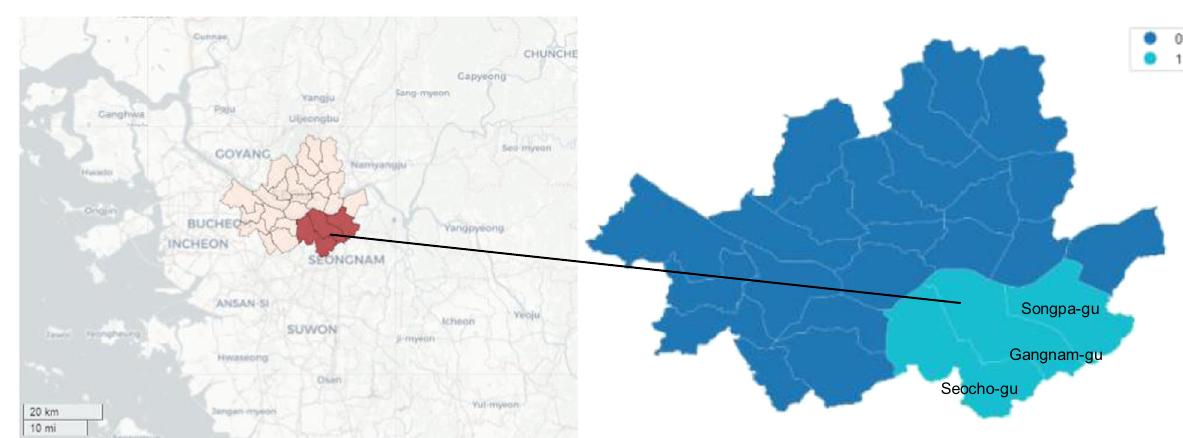
Fig. 8 Map visualization of clustering ( K = 2),